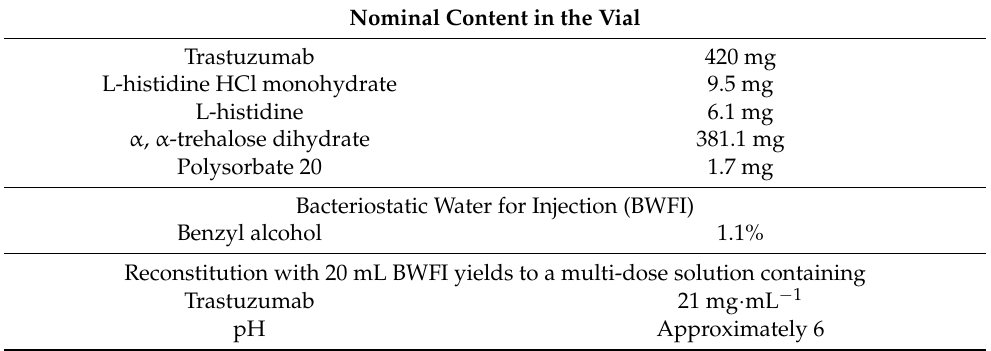
Table 15. Description of the multi-dose trastuzumab formulation Herceptin (Genentech, Inc., pack- age